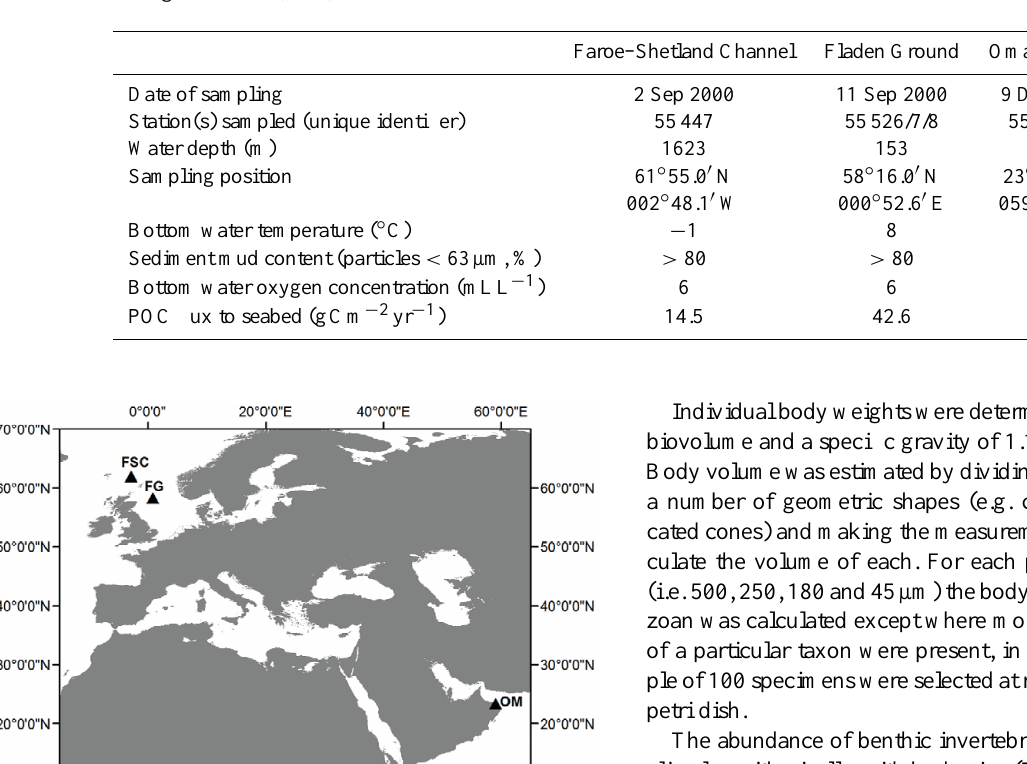
Table 1. Station data and environmental characteristics of the three study sites including particulate organic carbon (POC) flux to the seabed estimated following Lutz et al. (2007).